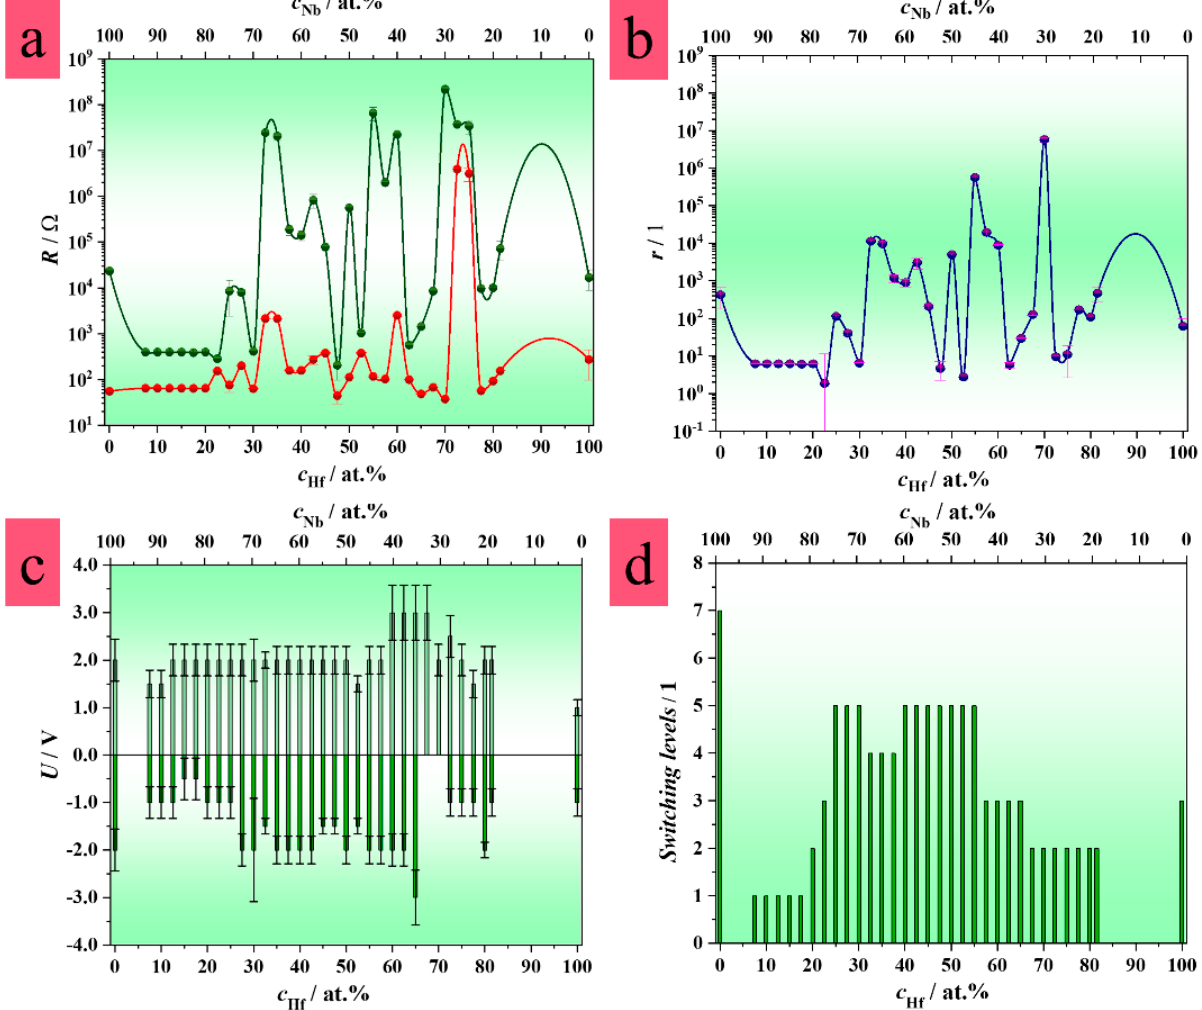
Figure 4. Compositional mapping in the Hf-Nb library system describing anodic memristors: ( a ) high and low resistive state values, ( b ) resistive state ratio, ( c ) switching voltage values, ( d ) number of switching levels.